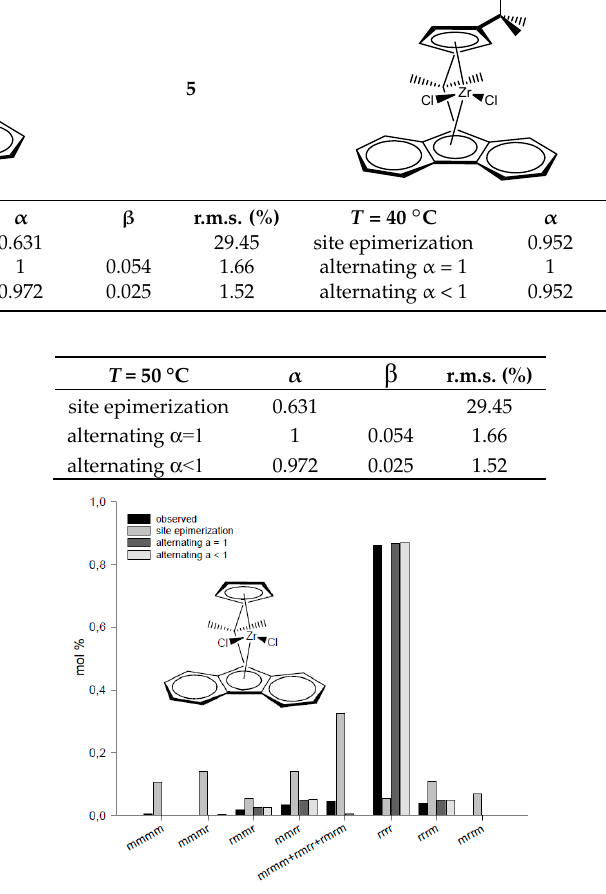
The r.m.s. Table 3. The r.m.s. errors for statistical models for propene polymerizations made with Table 3. The r.m.s. errors for statistical models for propene polymerizations made with 4 /methylaluminoxane (MAO) and 5 /MAO. Table 3. The r.m.s. errors for statistical models for propene polymerizations made with 4 /methylaluminoxane (MAO) and 5 /MAO. 4 /methylaluminoxane (MAO) and 5 /MAO. 4 /methylaluminoxane (MAO) and 5 /MAO. Table 3. The r.m.s. errors for statistical models for propene polymerizations made with 4 /methylaluminoxane (MAO) and 5 /MAO.